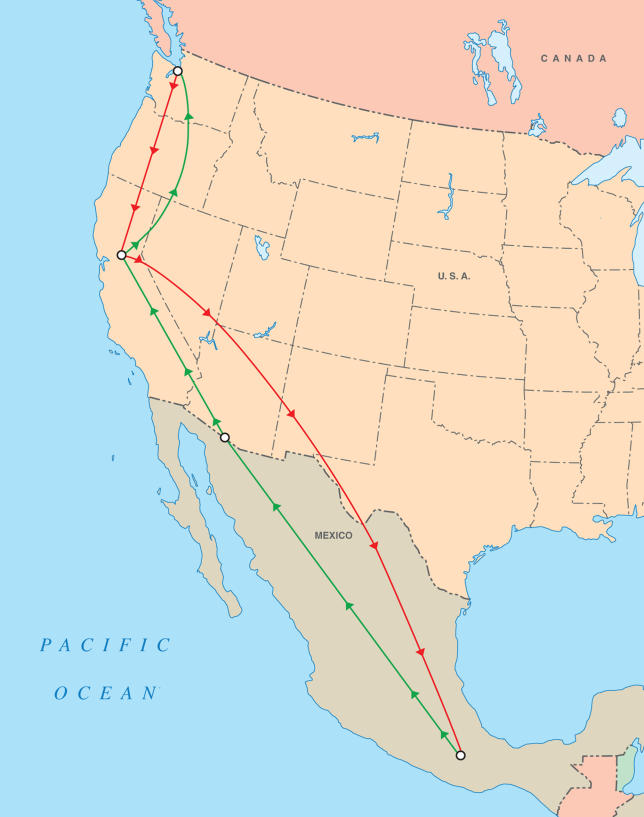
Map of Migration RouteThis map shows the route of migration field research followed by the anthropologist, from the Skagit Valley of Washington state to the central Valley of California, the mountains of Oaxaca, Mexico, the Arizona borderlands, and then back to central California and Washington state.(Illustration: Natalie Davis)